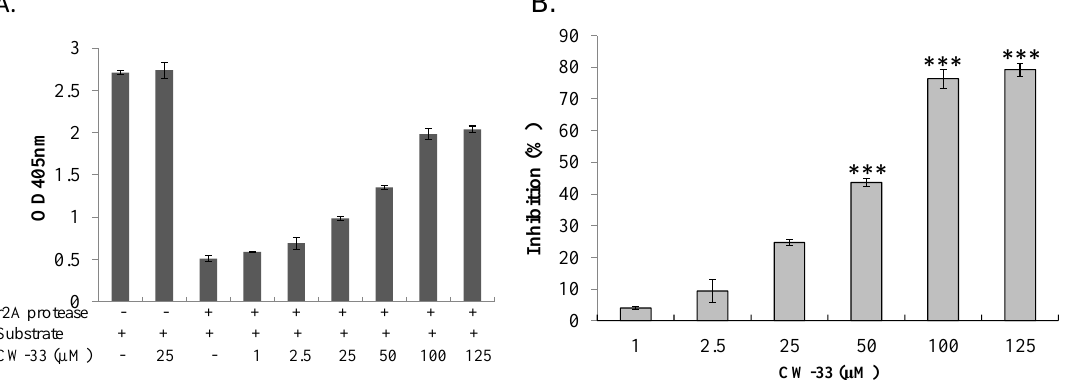
Figure 8. Inhibition by CW-33 on EV-A71 mediated cleavage of 2A protease-specific substrates. For in vitro inhibitory enzymatic assay of r2A protease ( A , B ), purified r2A protease at 5 µg/mL were added to substrate (10 µg/mL) and forthwith mixed with indicated concentrations of CW-33 for 2 h at 37 °C. Mixtures developed with ABTS/H 2 O 2 were measured at OD 405 , percentage inhibition of r2A protease activity calculated. *** p value < 0.001 by Scheffe test.